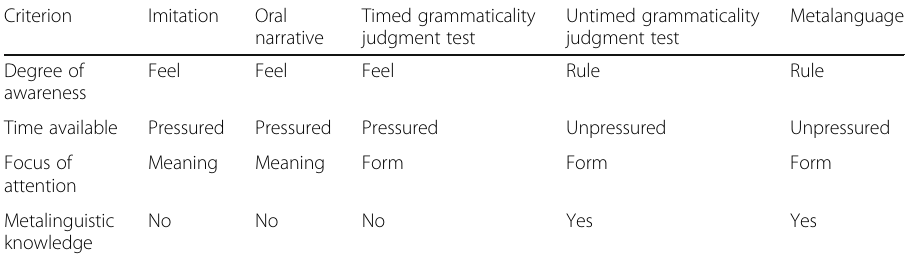
Table 3 Design features of explicit and implicit tests (Adapted from Ellis, 2005a, 2005b)